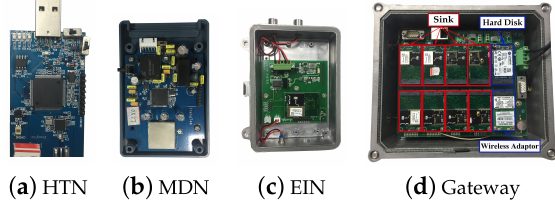
Figure 10. The hardware of wireless nodes and gateway.